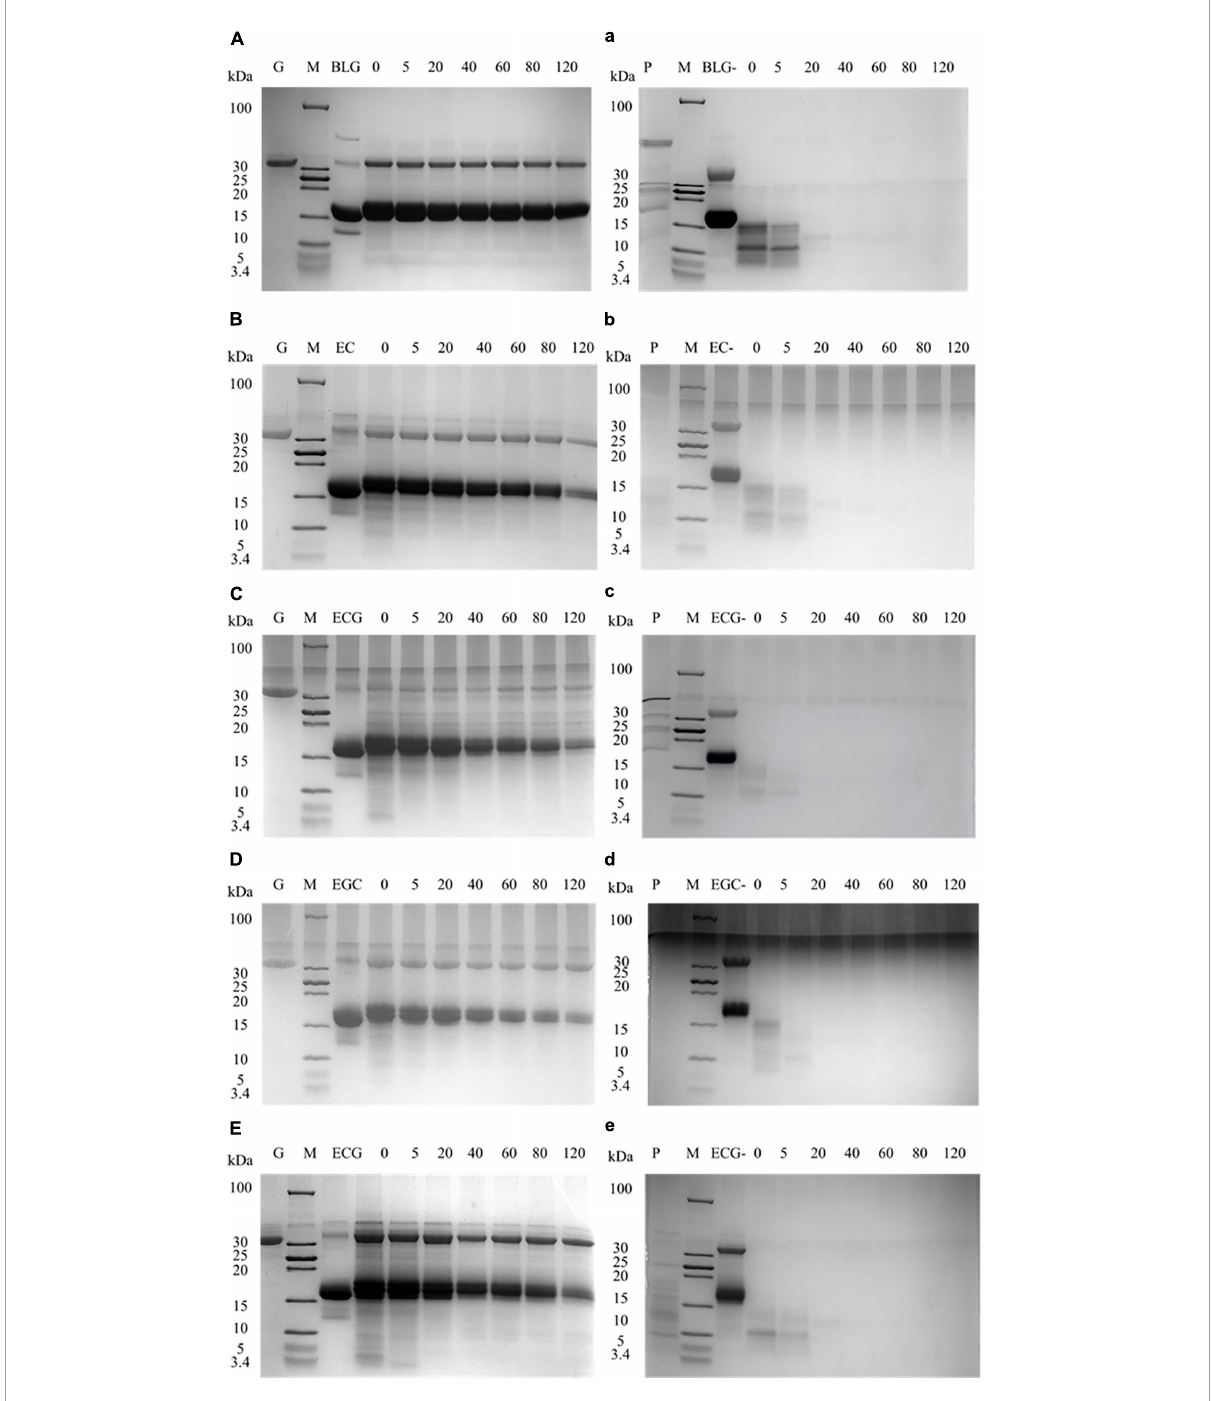
FIGURE3 Tricine-SDS-PAGE protein profiles of BLG-catechin complexes digested in simulated gastric fluid and gastrointestinal fluid of adult. (A–E) Tricine-SDS-PAGE protein profiles of BLG-catechin complexes digested in simulated gastric of adult. (a–e) Tricine-SDS-PAGE protein profiles of BLG-catechin complexes digested in the intestinal fluid of adult. G: pepsin; P: trypsin; M: marker; lane 3: BLG and its complexes (BLG represents the product of gastric digestion for 60 min); lane 4–7: digestion of 0, 5, 20, 40, 60, 80, and 120